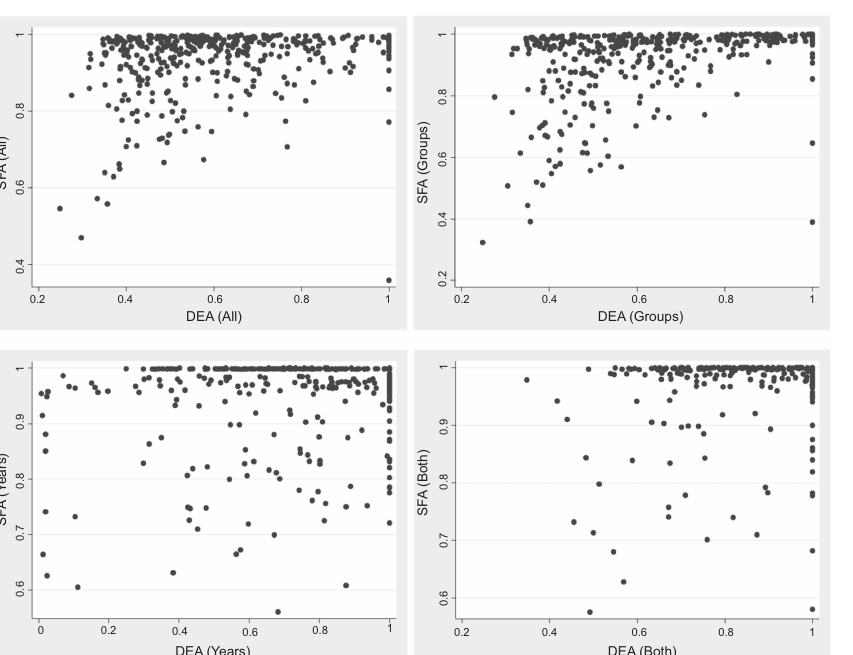
Figure 1. Comparison of efficiency score estimated by DEA and